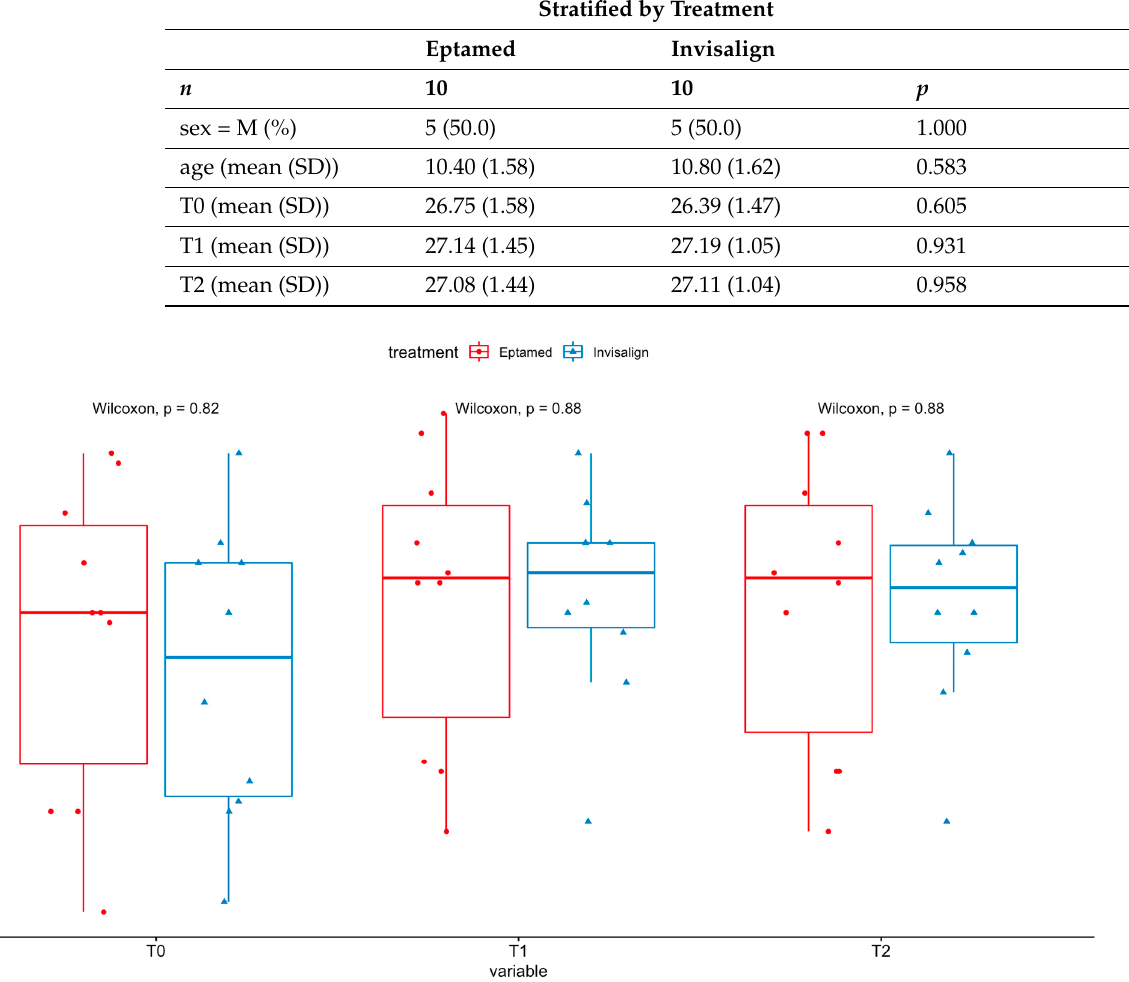
Figure 2. Bar plot of lower intercanine distance values stratified by timing according to group “Eptamed” vs. group “Invisalign”. The two groups exhibited the same results; the values of p were 0.82 at T0 and 0.88 at both T1 and